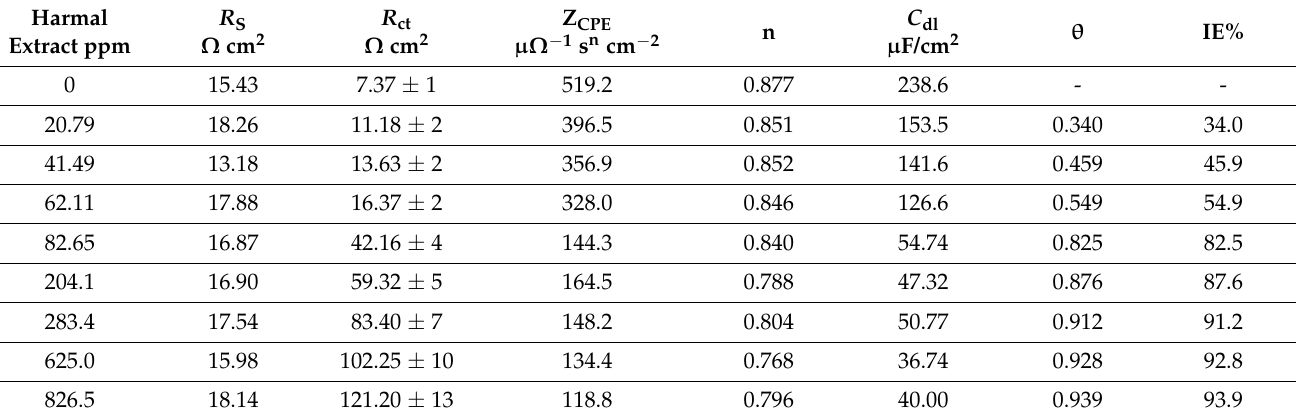
Table 1. Impedance parameters for Harmal extract on C-steel in 0.25 M H 2 SO 4 medium by fitting the equivalent circuit model A.